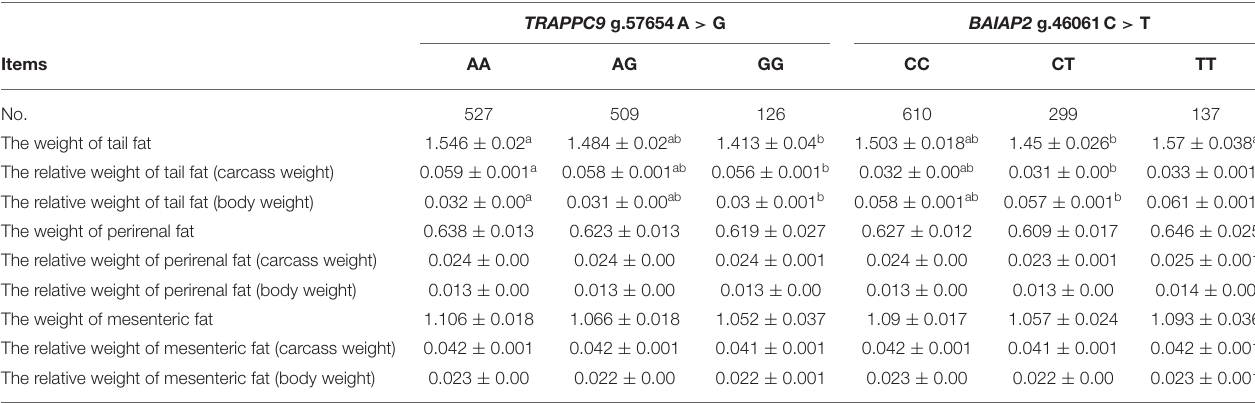
TABLE 6 | Analysis of the associations of sheep TRAPPC 9g.57654A > G and BAIAP2 g.46061C > T